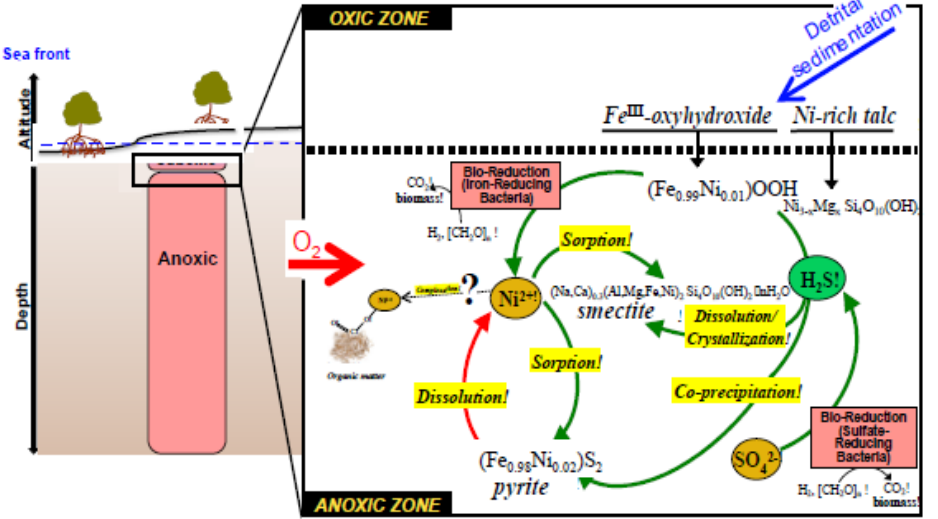
Figure 7. Ni cycling in mangrove soils focusing on the oxic–anoxic interface. In the anoxic zone, Ni-bearing Fe oxyhydroxides (blue arow) derived from detrital sedimentation undergo reduction reactions (green arrows) resulting the Ni incorporation into pyrite and sorption onto pyrite. Fe-oxyhydroxides may be reduced by Fe-reducing bacteria or by free sulfides produced by sulfate-reducing bacteria. Ni-rich clays such as Ni-rich talc are suspected to dissolved under reduced conditions, releasing Ni to porewater, possibly via Ni complexation by HS − . In contrast, oxygenation (red arrow) leads to oxidative dissolution of Ni-bearing pyrite which releases Ni 2+ that may be re-adsorbed onto FeS 2 . Source: [84]. Reproduced with permission from Elsevier.